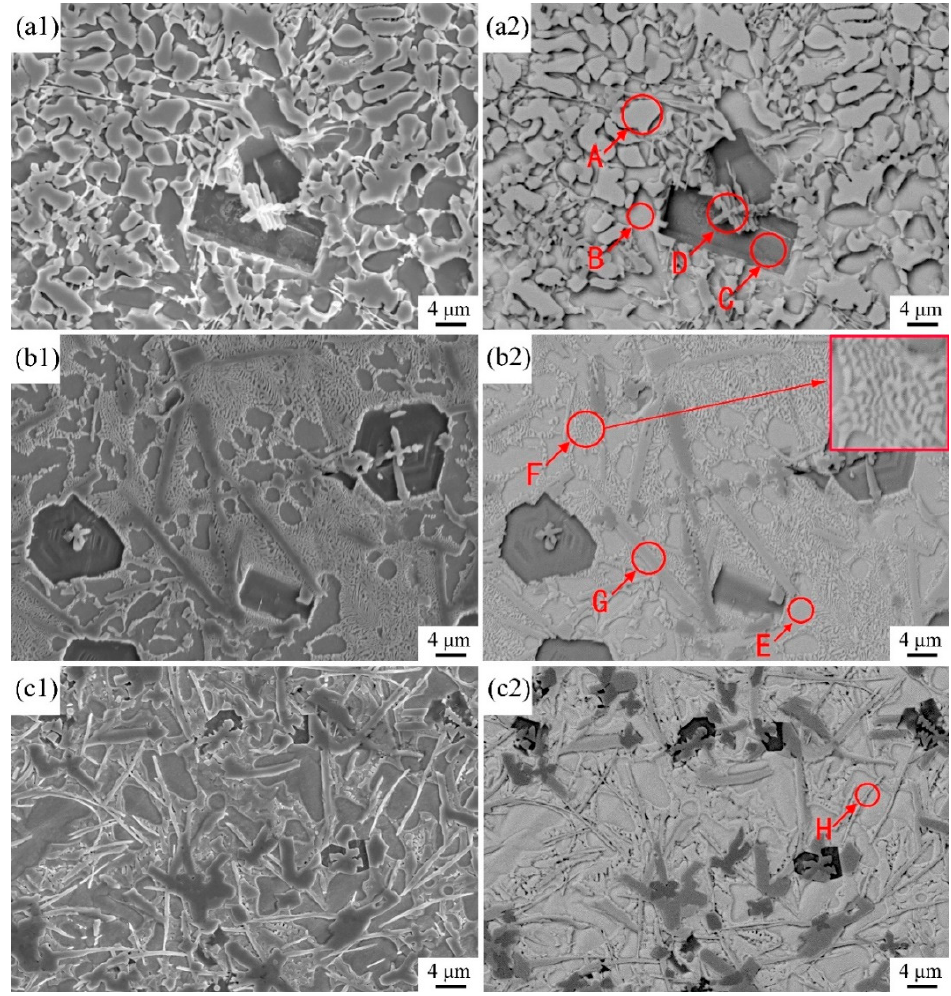
Figure 5. SEM and BSE image of cross ‐ sectional microstructure of the coatings: ( a1 , a2 ) Coating 1 for 5 mm ∙ s − 1 ; ( b1 , b2 ) Coating 2 for 11 mm ∙ s − 1 ; ( c1 , c2 ) Coating 3 for 17 mm ∙ s − 1 .